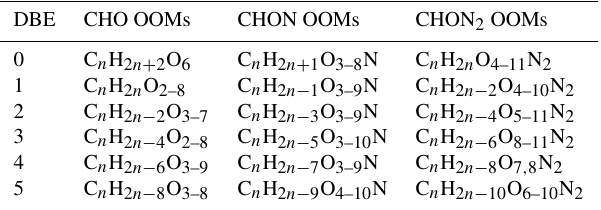
Table 2. Main CHO, CHON, and CHON 2 OOM species measured in this study. DBE CHO